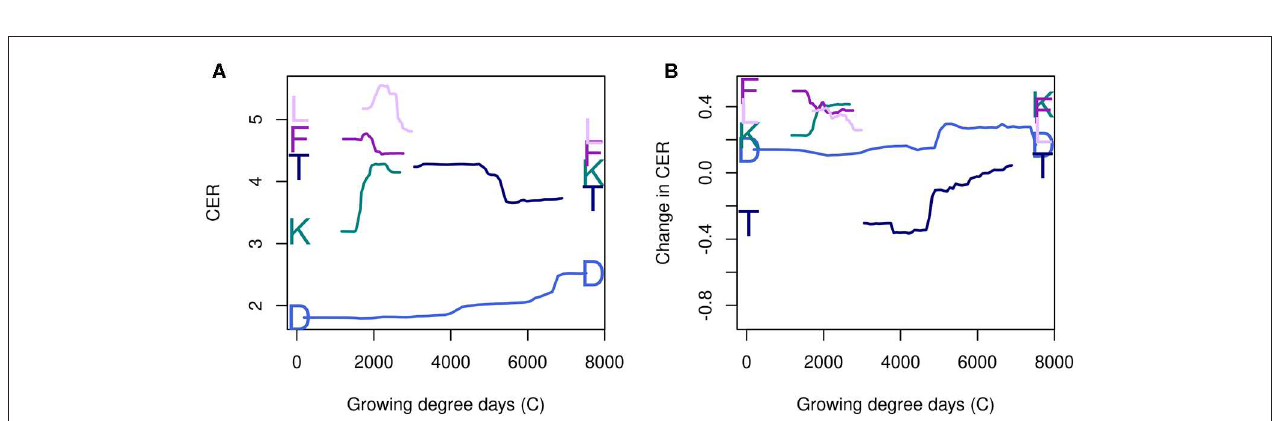
FIGURE 5 | Relative variable importance for the significant variables for each LRR model models of maximum crop effective richness (A) and change in crop effective richness (B) , 2008–2018. The darkest is the most important for each region; lighter colors are relative to that maximum. Region labels include the variance explained for that model. Color scale is as for Figure 1B